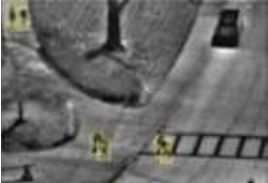
Figure 23. Detection of ROIs with possibility of pedestrians’ presence.